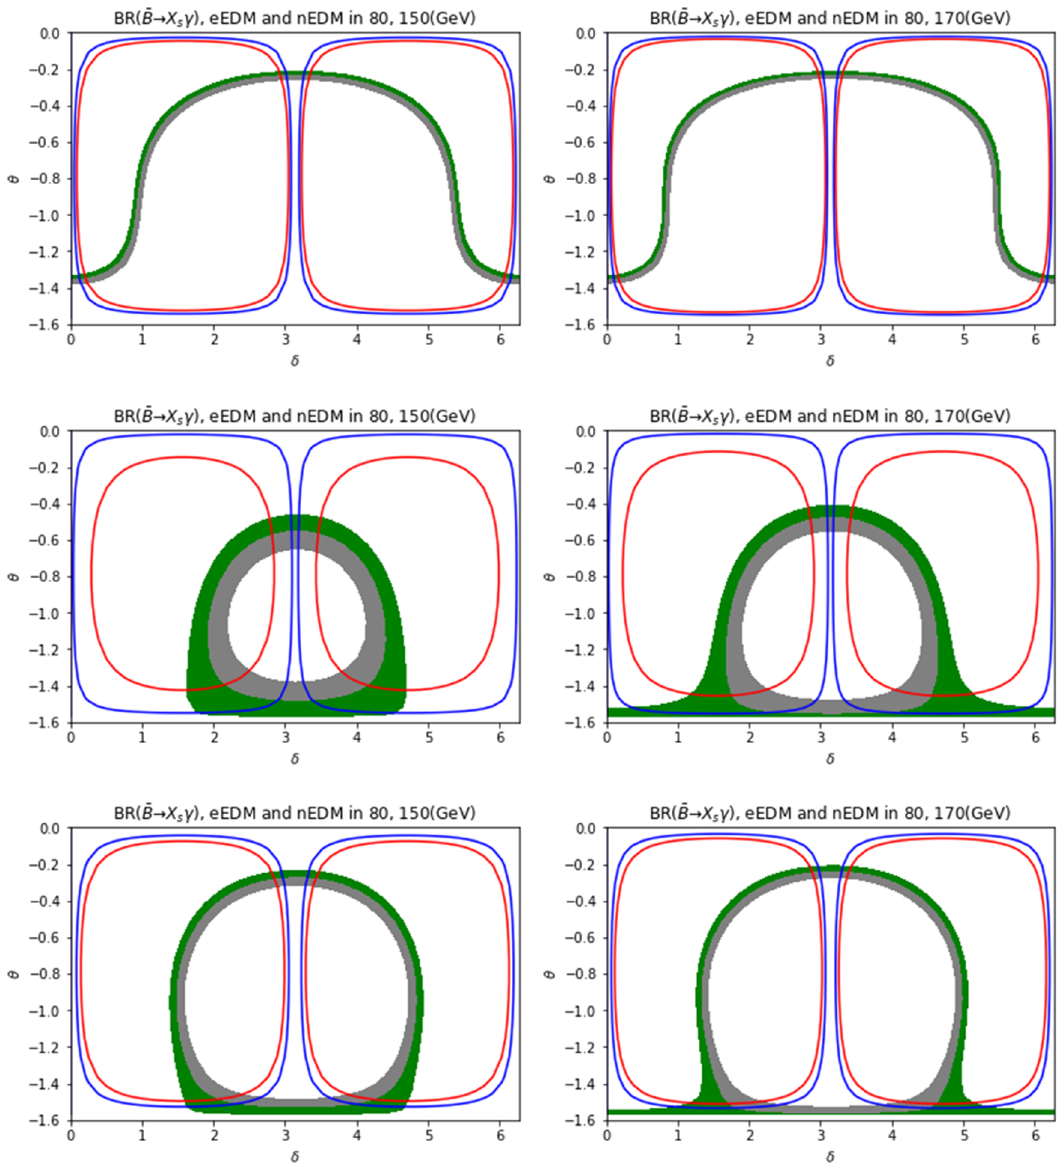
Figure 15 . The allowed regions from ¯ B → X s γ (within the green and grey shaded areas), eEDM (outside the blue curves), and nEDM (outside the red curves) in the [ δ, θ ] plane, with M and M = 150 (left) or 170 (right) GeV. From top to bottom, (tan β, tan γ ) = (5 , 0 . 5) ; (5 , 1) ; H + 3 and (10 , 1)